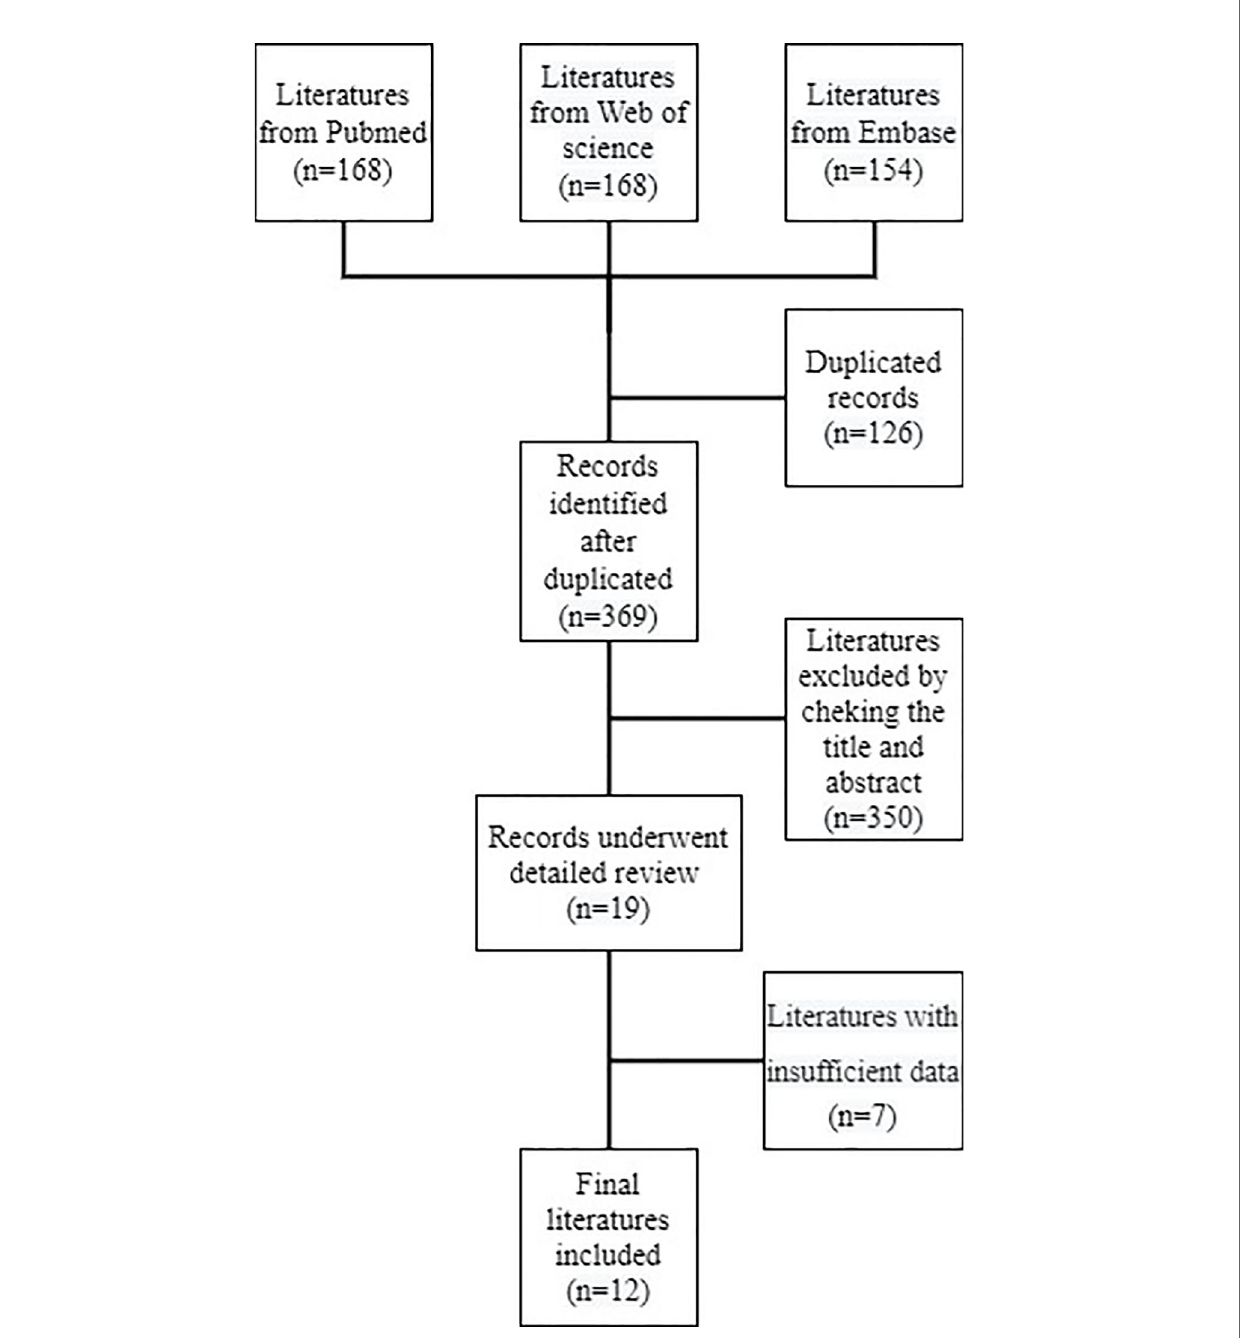
FIGURE 1 | Flow diagram of record